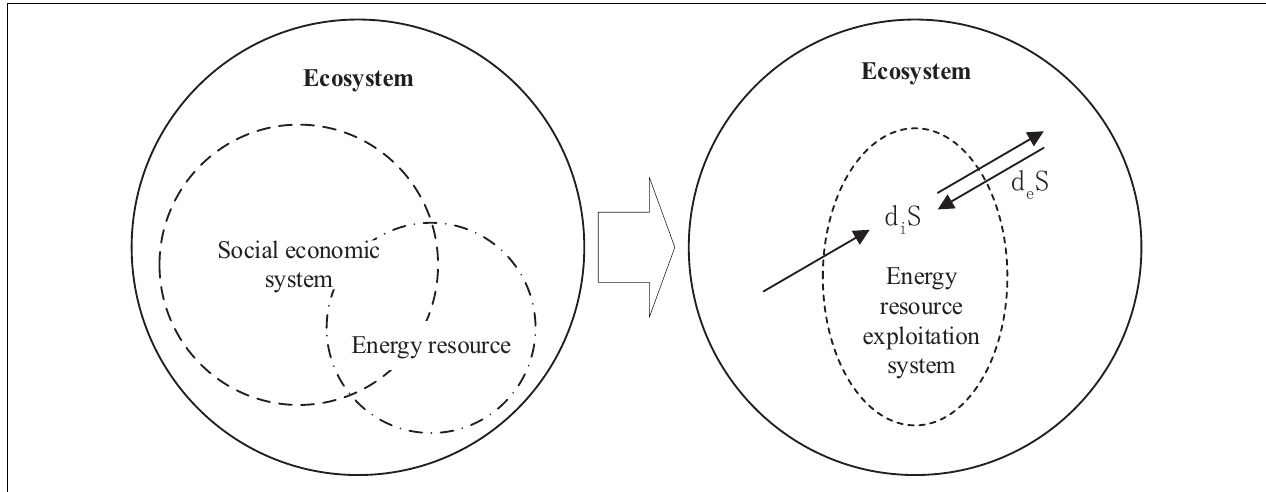
FIGURE 3 | An energy resource exploitation system and its dissipative structure.